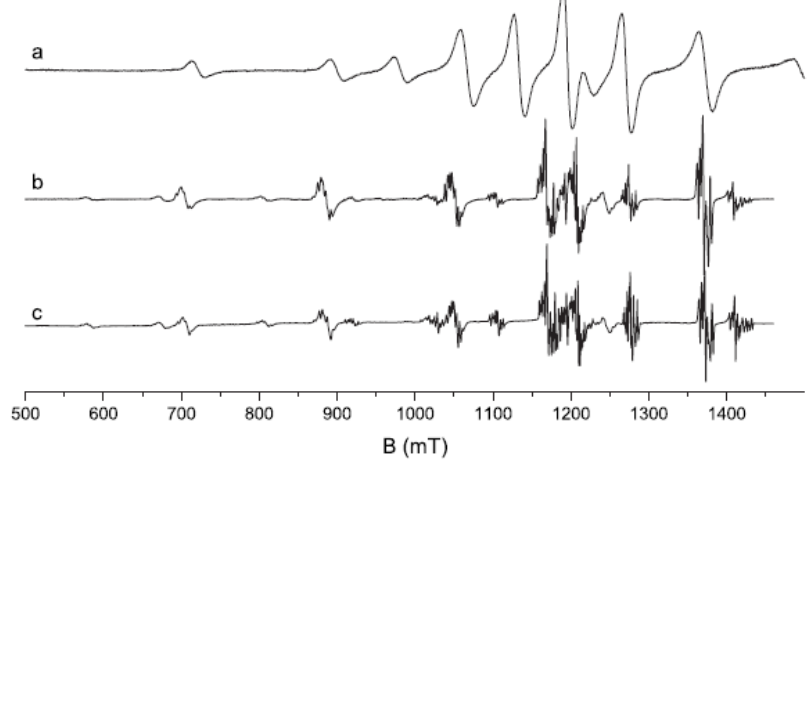
Figure 26. Normalized Q band spectra with magnetic field  to the plate (<100> spectrum) of an annealed Agfa NIP at RT ( a ) and at 4 K ( b ) and of a commercial NIP at 4 K ( c) [98] (reproduced with permission from Frank